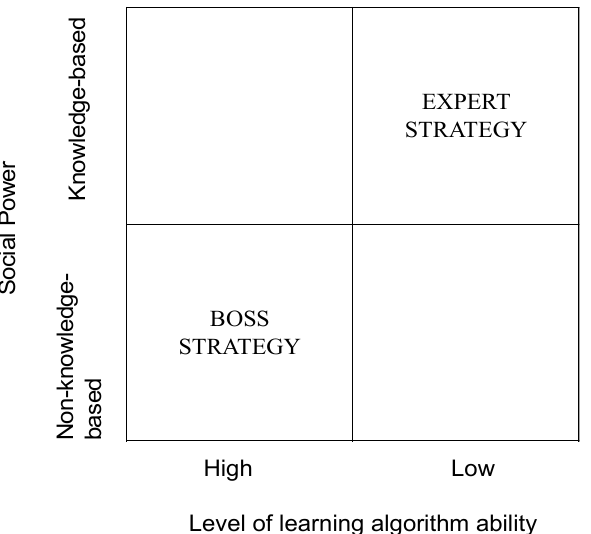
Figure 3. Power strategy matrix of AI adoption in healthcare.